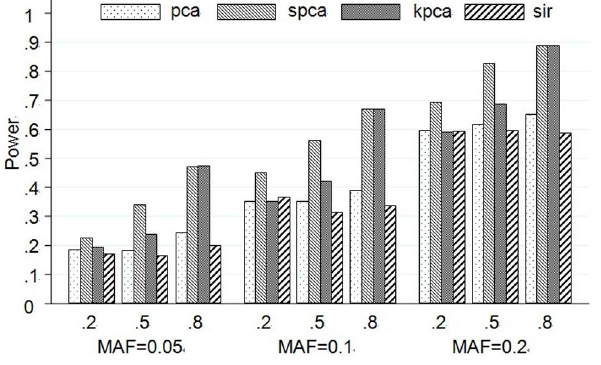
Figure 1. Test powers at single causal SNP model based on 10 SNPs. The plot shows the powers (y-axis) of each method over the different LD and MAF structures (x-axis). The first line of x-axis represents LD, and the bottom line is MAF.